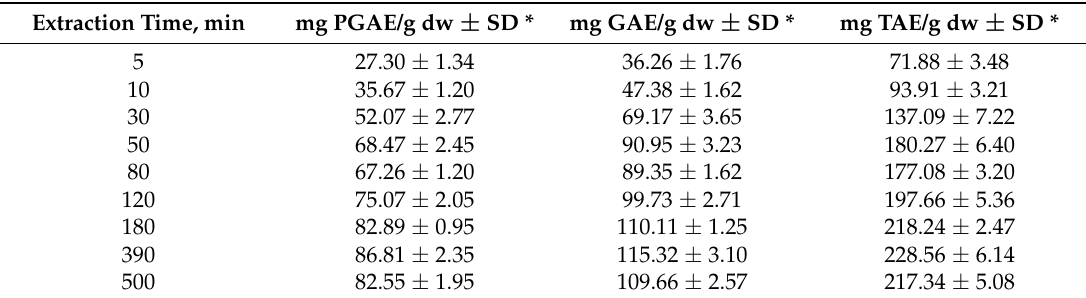
Table 1. Total polyphenol kinetic expressed as tannic acid, gallic acid, and pyrogallic acid equivalents in mg per g dry weight of the Cistus incanus leaf, stalk and bud